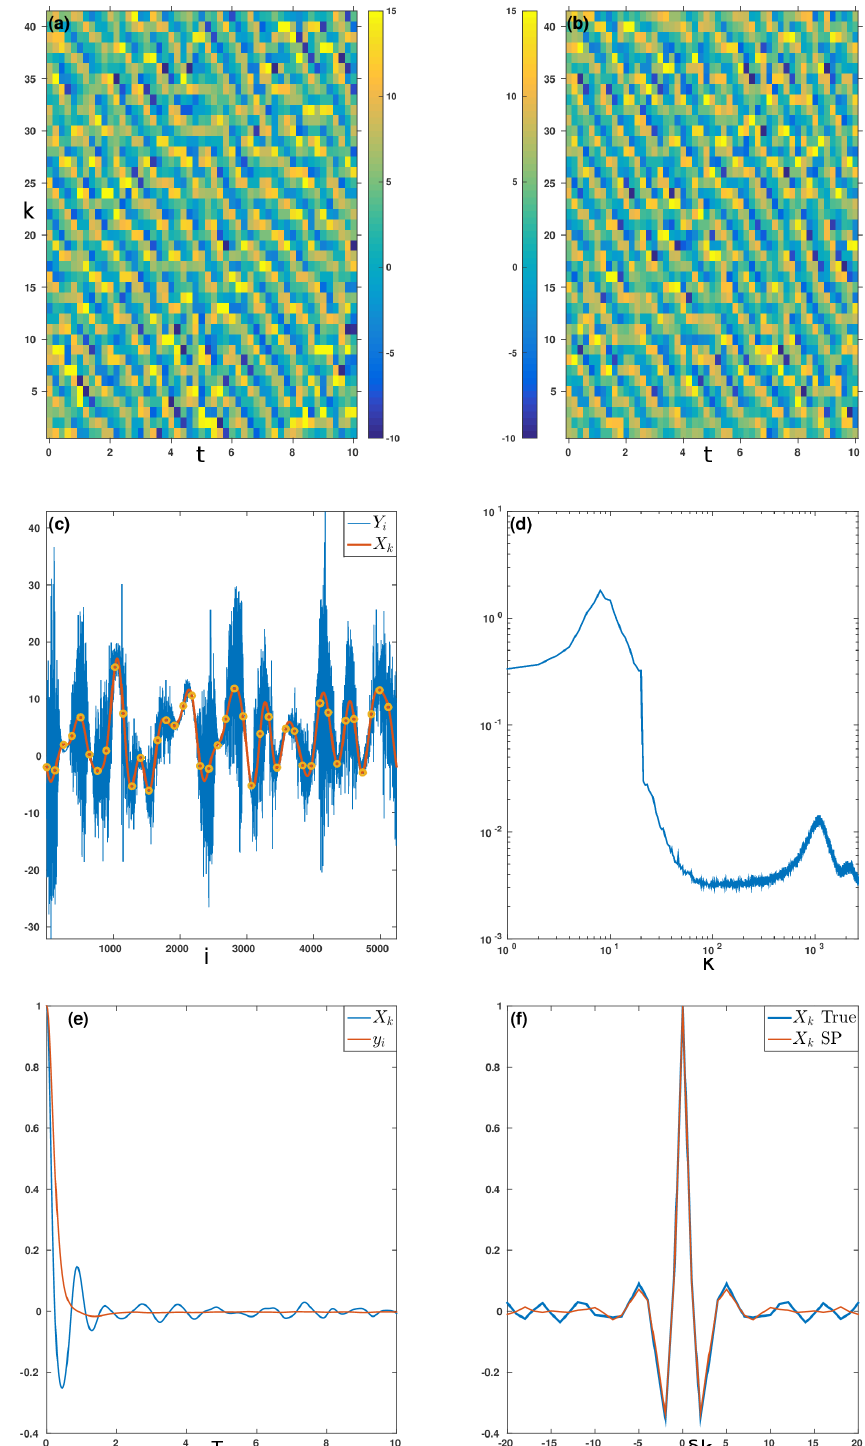
Figure 2. Climatological statistics in regime II. Panels are the same as Fig.